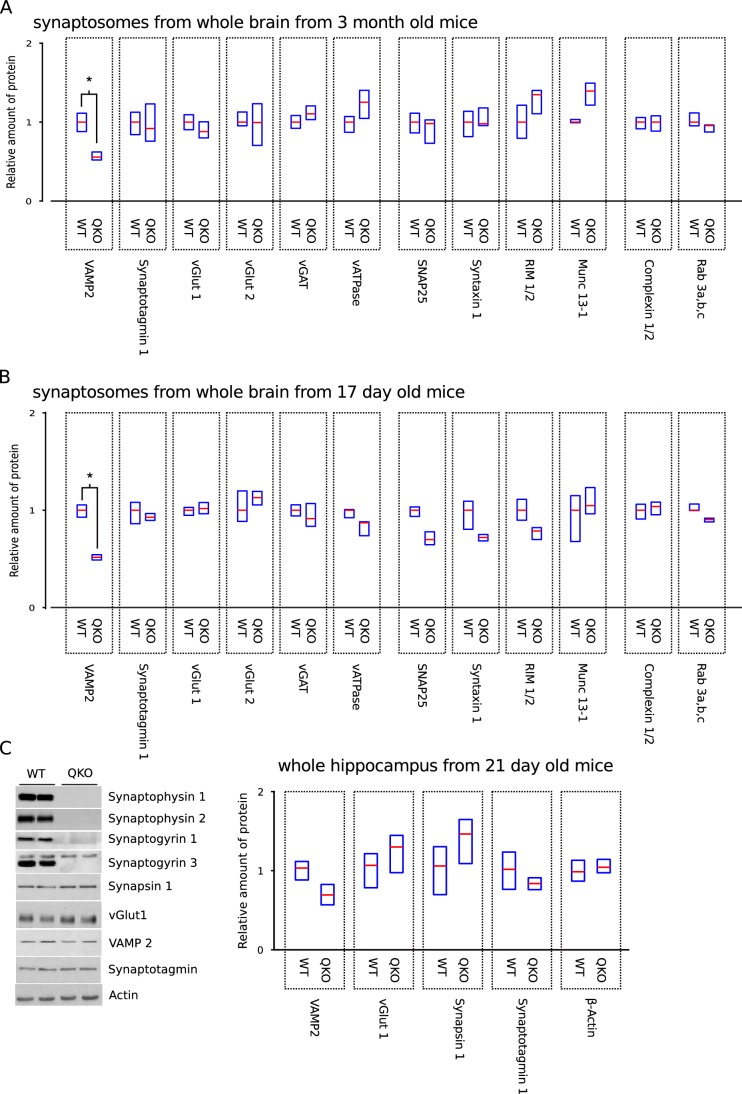
More extensive biochemical analysis including more proteins, different ages, and different methods for sample preparation.More extensive biochemical characterization of QKO brains. (A,B) Full panel of synaptic proteins analyzed in purified synaptosomes from whole brain of 3-month-old and 17-day-old WT and QKO mice; a subset of the results from 3-month-old are plotted in Figure 1. Cohorts of 5 animals (3 males, 2 females for each genotype) were used for younger mice. *p<0.05; Wilcoxon rank sum with Bonferonni correction for multiple comparisons; n ≥ 6. (C) Representative immunoblots and quantification of the indicated proteins in homogenates of hippocampus from n = 4 21-day-old male mice for each genotype. No significant differences between WT and QKO were detected for any of the proteins (two sample t-tests with significance levels adjusted using the Bonferroni correction for multiple comparisons). In all panels, horizontal lines are median values, boxes are the middle two quartiles.